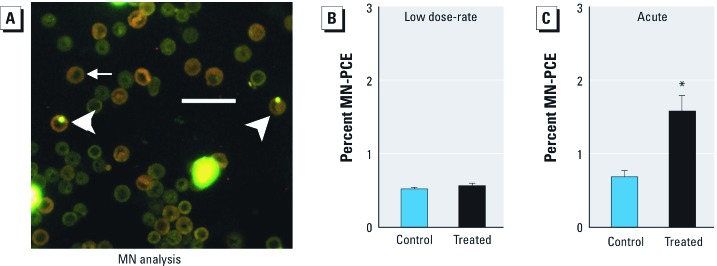
Representative image of a PCE-containing micronuclei (MN-PCE; arrowheads) and of a normal RBC (arrow) isolated from bone marrow; bar = 20 µm (A). Low dose-rate (0.0002 cGy/min) irradiation (B) does not induce micronuclei in PCEs, whereas acute (7.1 cGy/min) irradiation (C) does. Data (mean ± SE ) are representative of two independent experiments; percent MN-PCE was calculated from > 2,000 scored PCE per sample. *p < 0.05 using unpaired two-tailed Student’s t-test.